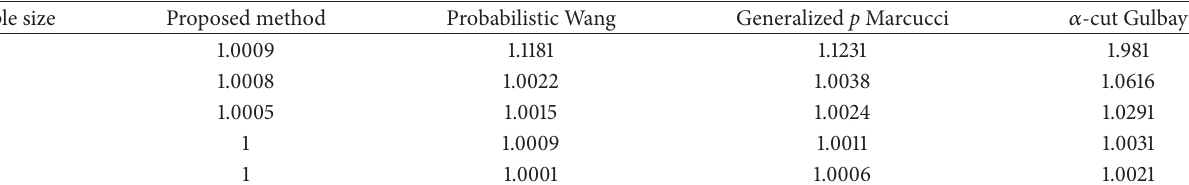
Table 6: ARL for different approach when there is a shift equal to 2𝜎 . 1